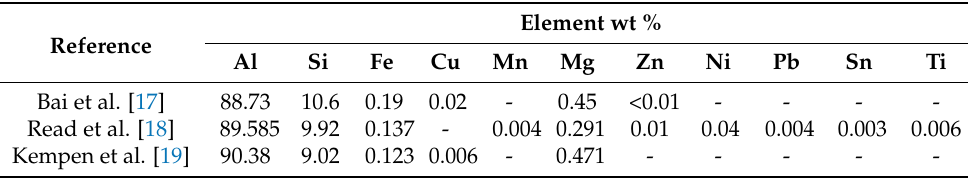
Table 4. Chemical composition of AlSi10Mg powders used in Bai et al. [17], Read et al. [18] and Kempen et al.